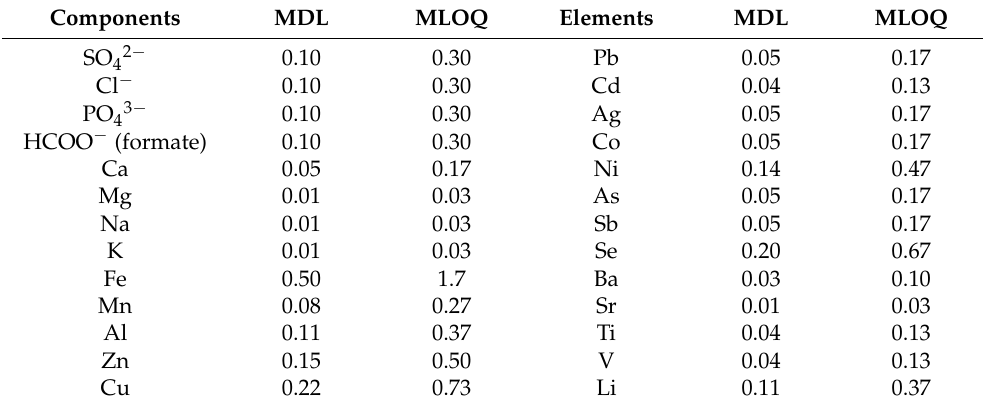
Table 1. Metrological parameters of capillary electrophoresis and ICP-MS methods (SO 42 − –K in mg/L, Fe–Li in µ